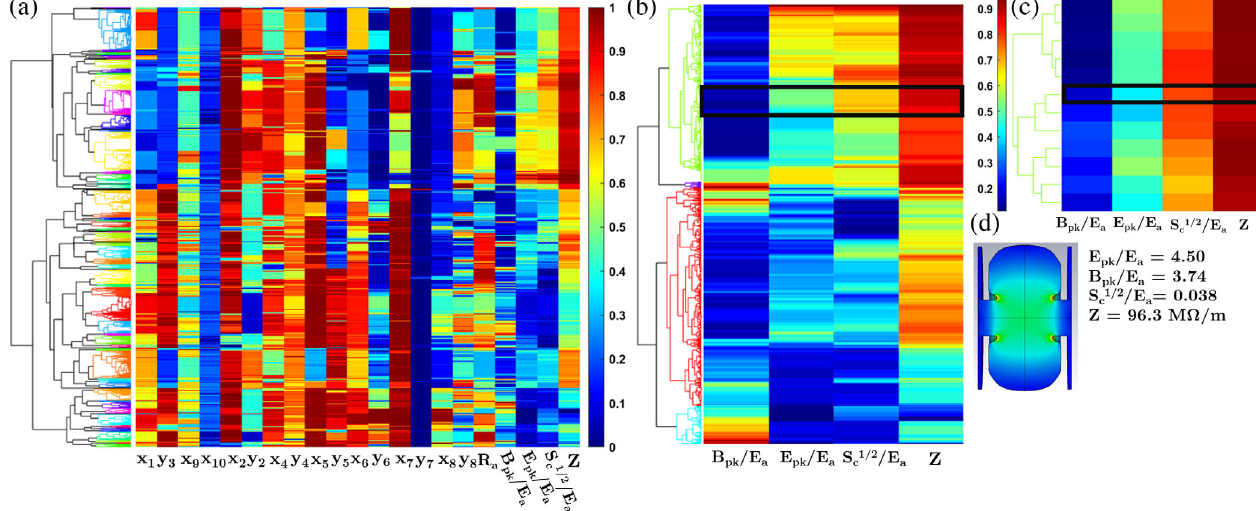
FIG. 22. (a) Heat map showing both design and objective space. (b) Heat map showing only objective space. (c) Enlarged section with =E low values of E and high Z . (d) Example of a selected cavity using the heat map method. pk acc